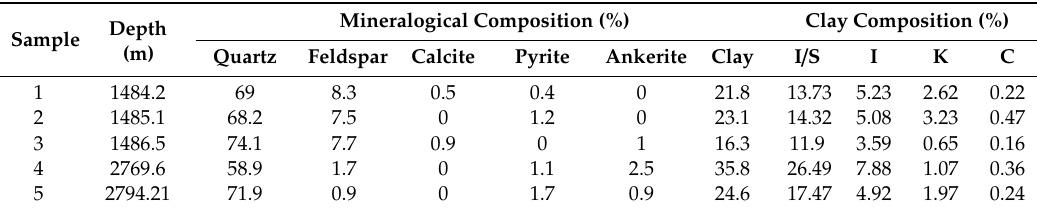
Table 1. The compositions of minerals from the P 1 t tight sandstone